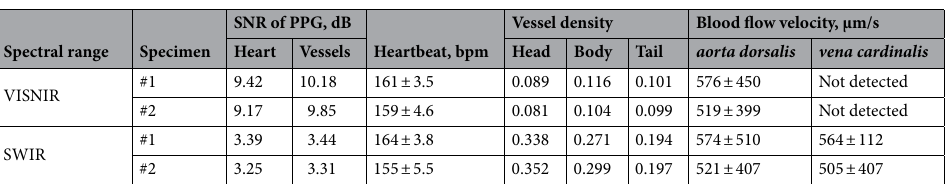
Table 2. Quantitative cardiovascular data measured in VISNIR and